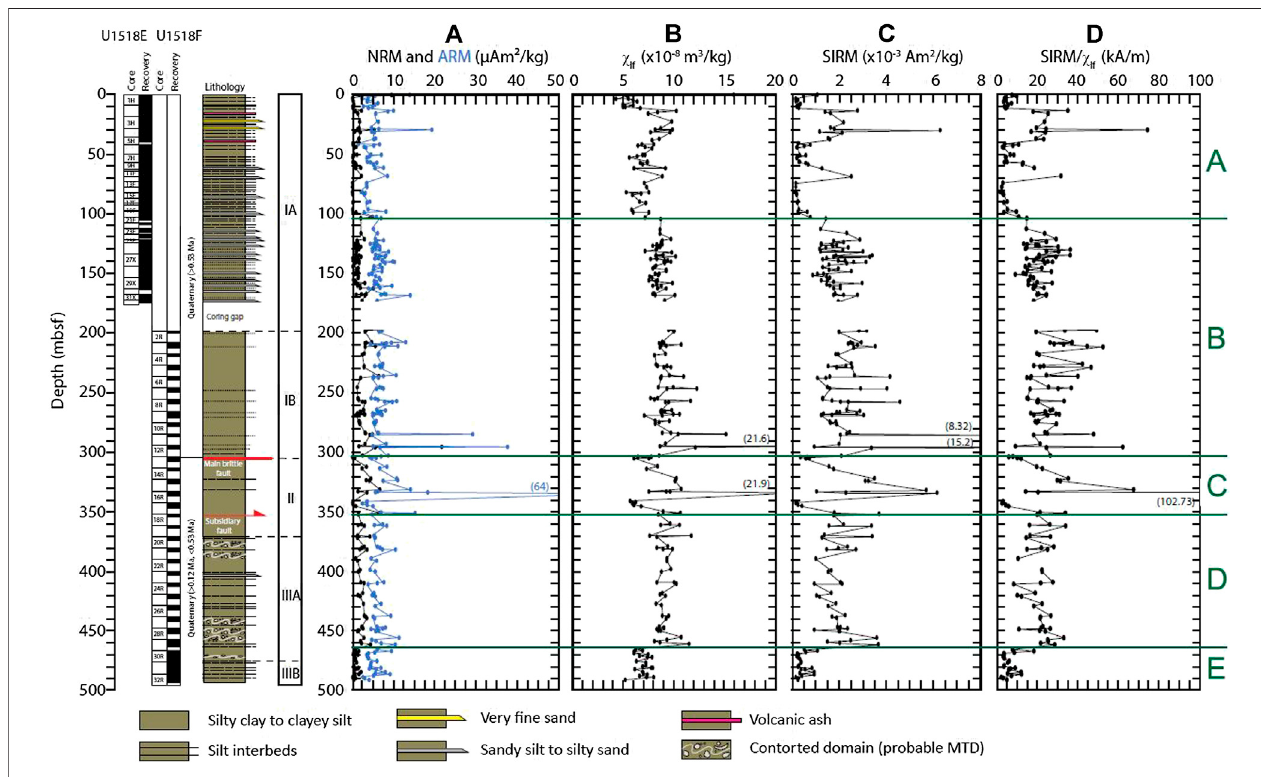
FIGURE 2 | Downhole rock magnetic parameters at Site U1518 (A) Natural Remanent Magnetization (NRM) and Anhysteretic Remanent Magnetization (ARM) (B) Magnetic susceptibility χ lf (C) Saturation Isothermal Remanent Magnetization (SIRM) (D) SIRM/ χ lf ratio. Spikes in NRM, ARM, χ lf , and SIRM are likely due to coarser lithology. Zones A to E, de fi ned from coercivity variations (see Figure 3 ), are indicated. Core recovery, age and lithologic description are from Wallace et al.